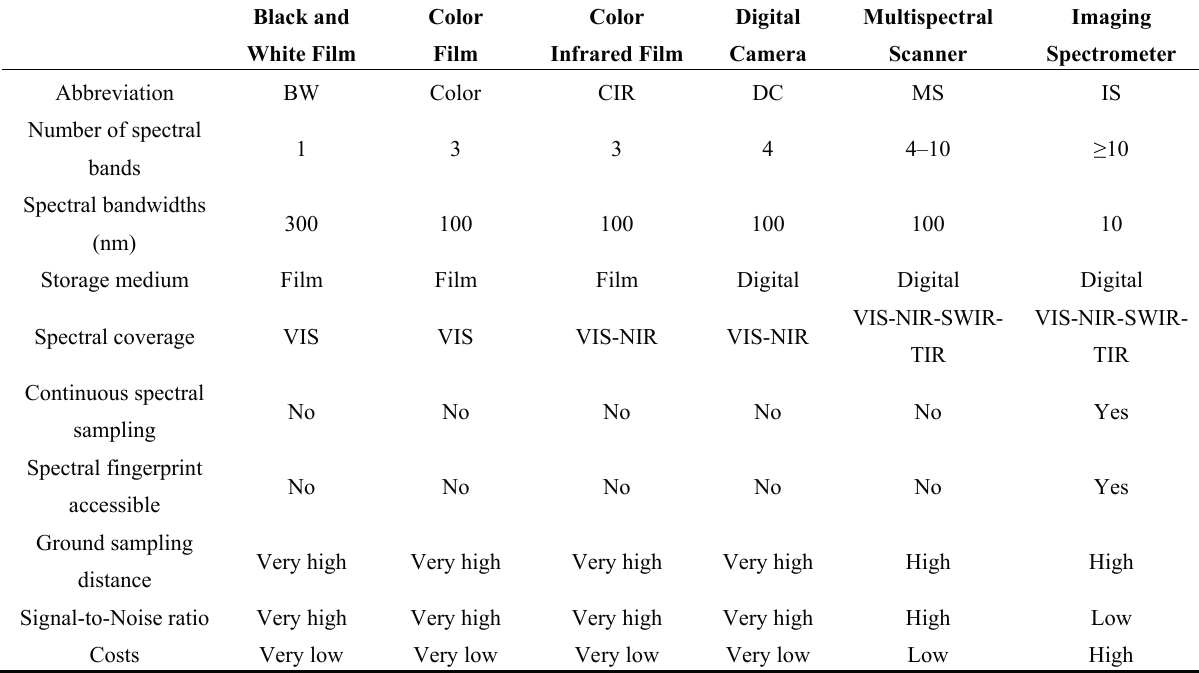
Table 1. Main characteristics of optical imaging sensors used for archaeological